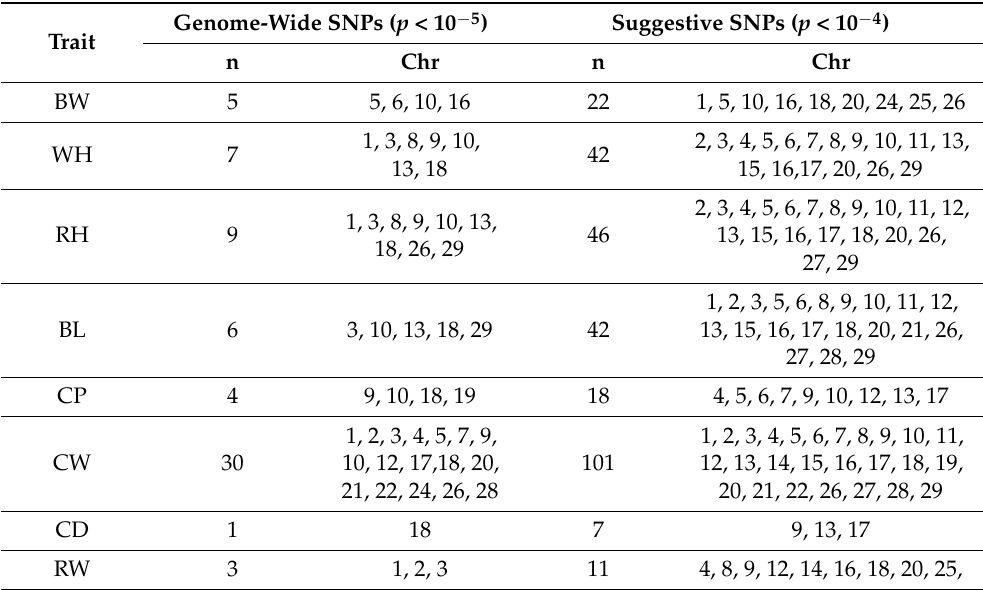
Table 2. Quantitative distribution of significant SNPs on chromosomes associated with body weight and body conformation traits in Karachai goats at age 8